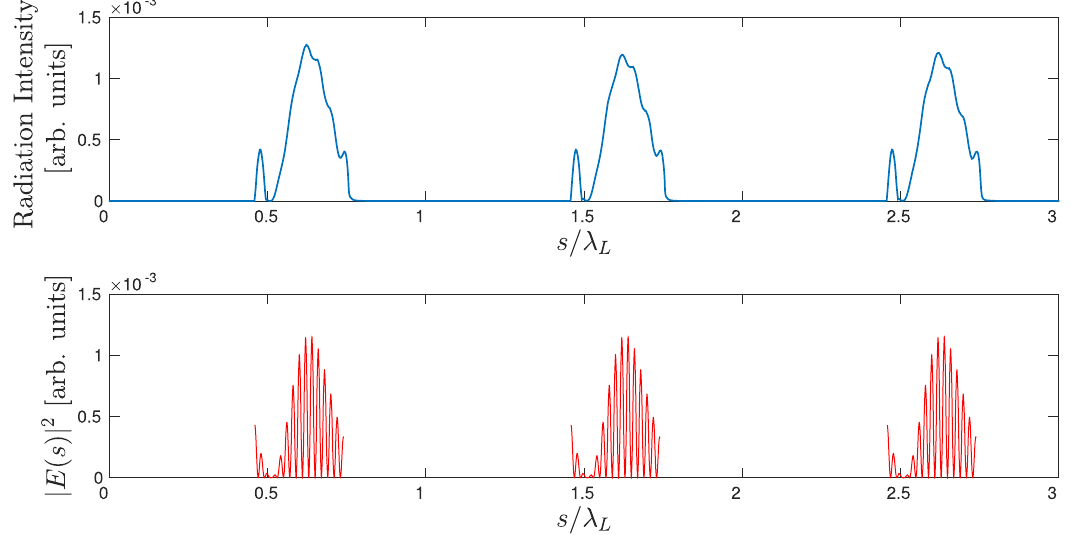
FIG. 4. Comparison of the electromagnetic field intensity from P uffin (top) and the analytical formula (18) (bottom) for the squared electric field showing the pulse train structure. The longitudinal extent of this plot covers three laser wavelengths, and the harmonic up- conversion factor is 25. Note that from the definition of s , the radiation slips to the right in this plot, so the most recent radiation is found at the leftmost portion of the pulses.